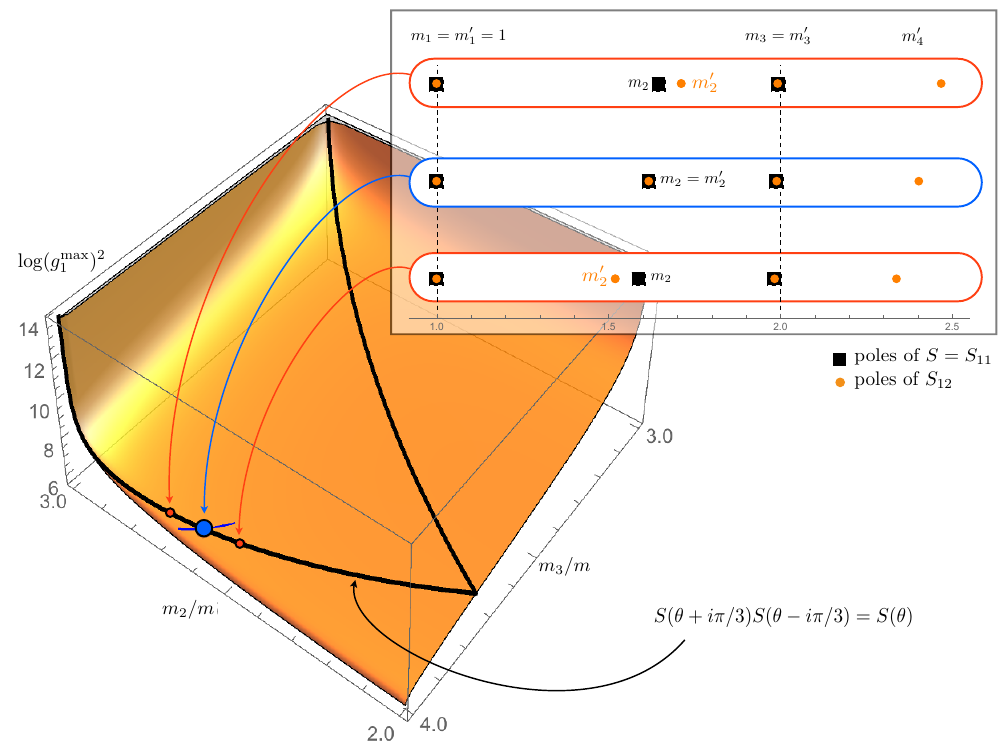
Figure 12 . Blow up of region B from (cid:12)gure 11. The thick black line is where the cubic fusion property (3.4) holds (i.e. assumption (1) in the discussion of section 3). In the upper right corner we plot the s-channel poles of S 12 versus those of S . We see that, following the thick black line, only at the blue dot does S 12 have poles at the same locations as S indicating that assumption (3) from section 3 also